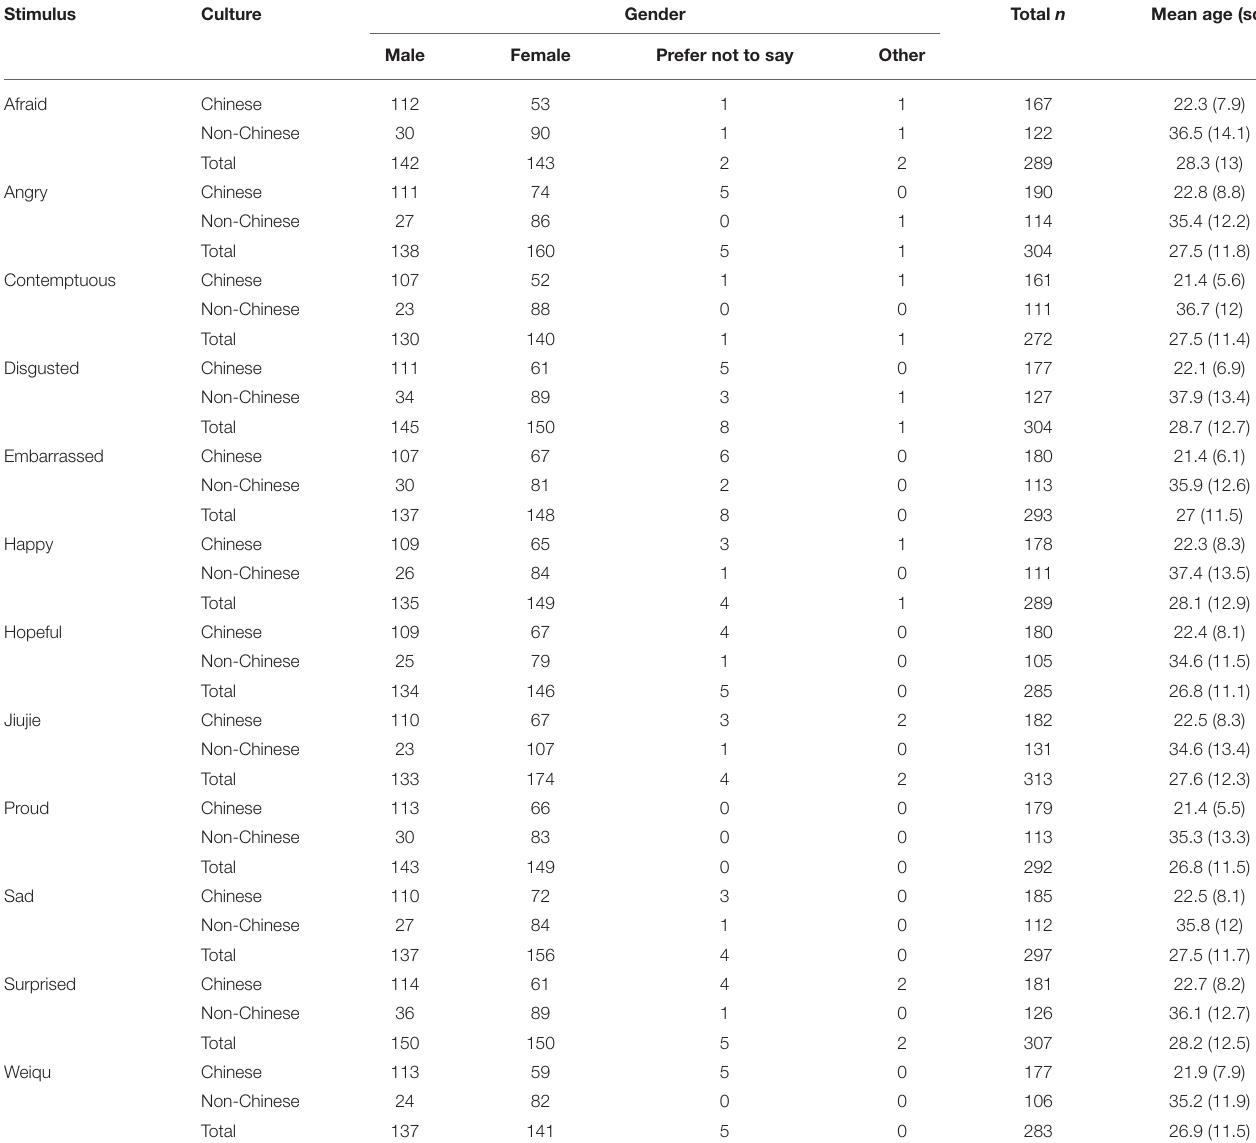
TABLE 1 | Demographics of the observations ( n ) for each stimulus.